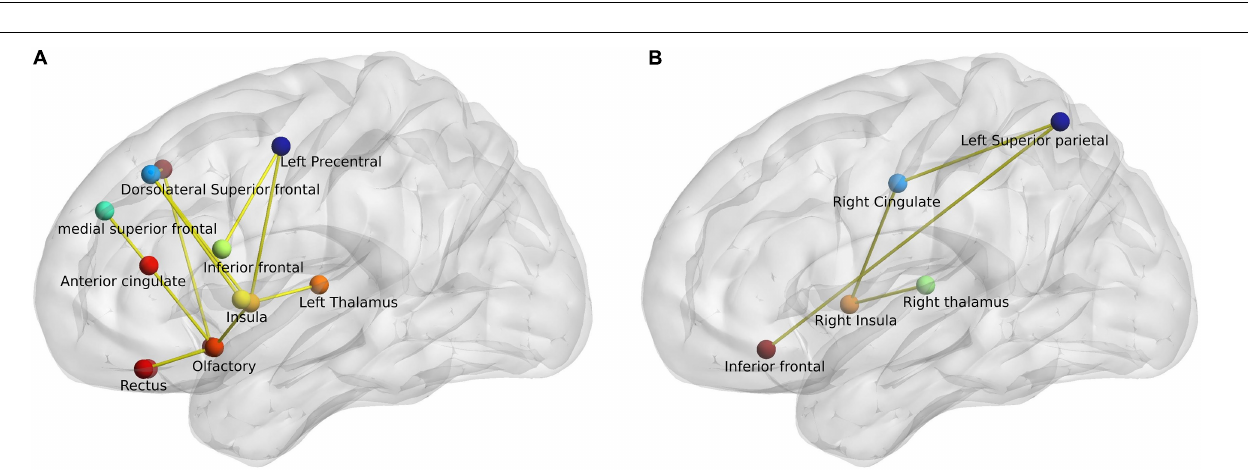
FIGURE 2 | Network measures. The boxplots shows the mean eccentricity (A) and mean characteristic path length (B) obtained from both cohorts. The Nathan Kline Institute (NKI) dataset of healthy control groups (shown here in blue) showed no significant difference (n.s) between middle-aged healthy controls (HC M − NKI ) and elderly healthy controls (HC E − NKI ). The young (HC Y ) or middle-aged (HC M ) healthy controls and Parkinson’s disease (PD) patients from Kiel cohort (shown here in orange) showed significant difference in both network measures. Significance was tested using a two-sample Kolmogorov–Smirnov test with the Bonferroni-Holm method for multiple comparisons correction. ∗ Characteristic path length: HC Y -PD ( p = 0.0013), HC M -PD ( p = 0.0264); eccentricity: HC Y -PD ( p = 0.0242), HC M -PD ( p = 0.0275). The black circles in the plot represent the data points.